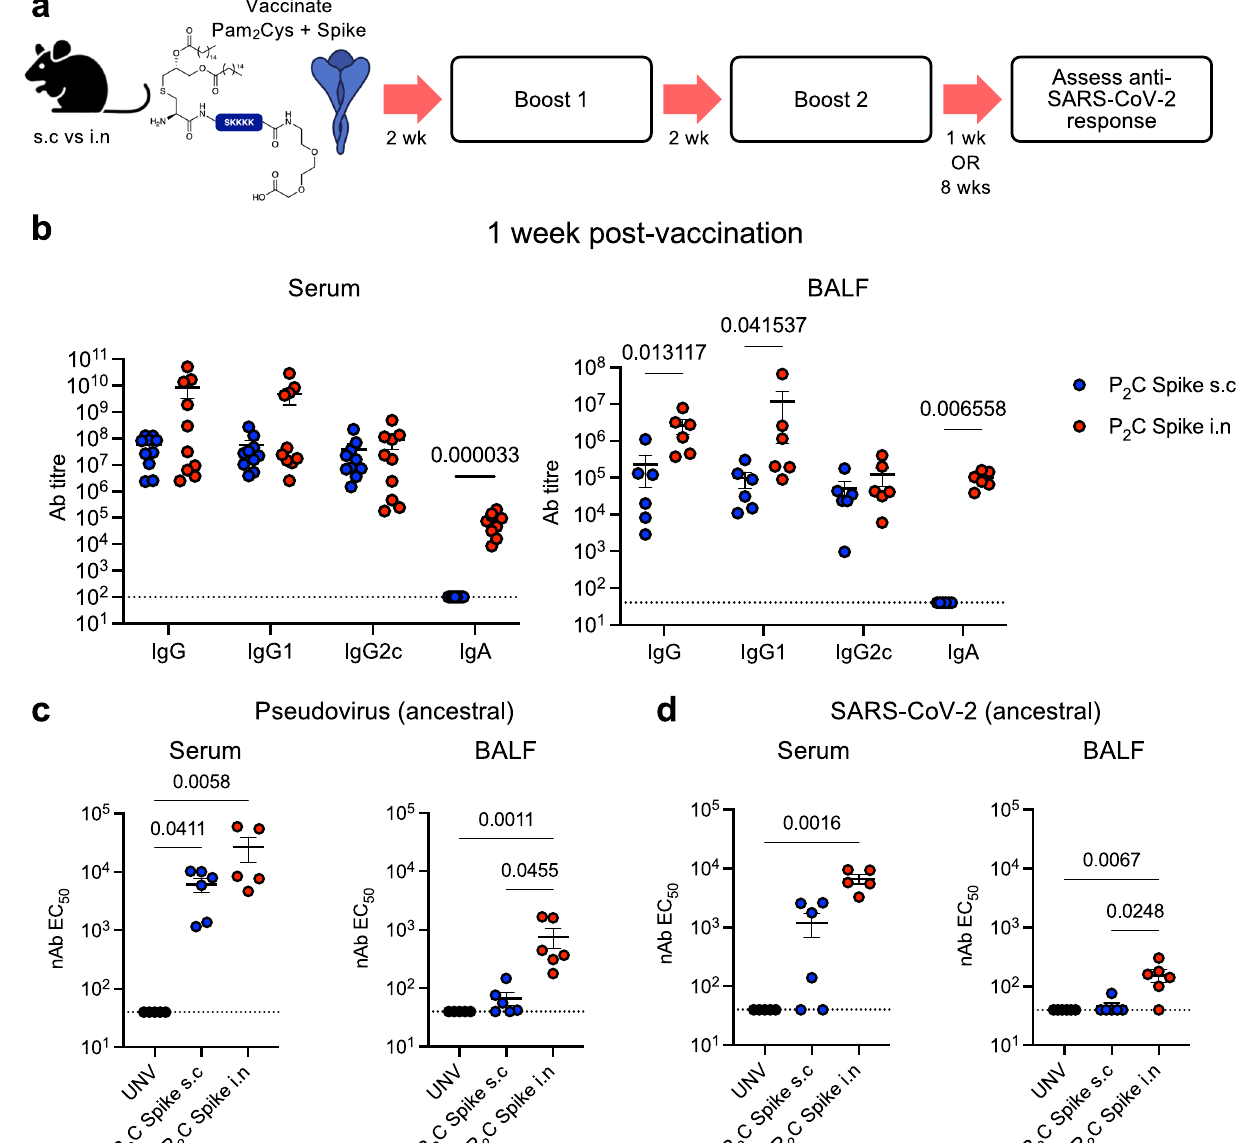
Fig. 1 | Vaccination with Pam 2 Cys Spike induces potent Spike-speci fi c neu- tralizing antibody responses, which is enhanced in the airways with mucosal vaccination.a Experimentaloutline.C57BL/6micewereimmunizedwithPam 2 Cys (P 2 C) and Spike protein s.c (blue) or i.n (red) three times, two weeks (wks) apart. Immunogenicity was assessed one week (wk) post fi nal vaccination. Control mice were unvaccinated (UNV; black). b Anti-spike IgG isotypes and IgA titres (log 10 scale)in the serum ( n =10 animals) and broncho-alveolar lavage fl uid (BALF) ( n =6 animals),determinedbyELISA,usingthemean+3SDofthelevelin1:100dilutionof sera or 1:40 BALF from unvaccinated mice as the cut-off. c Neutralizing antibody